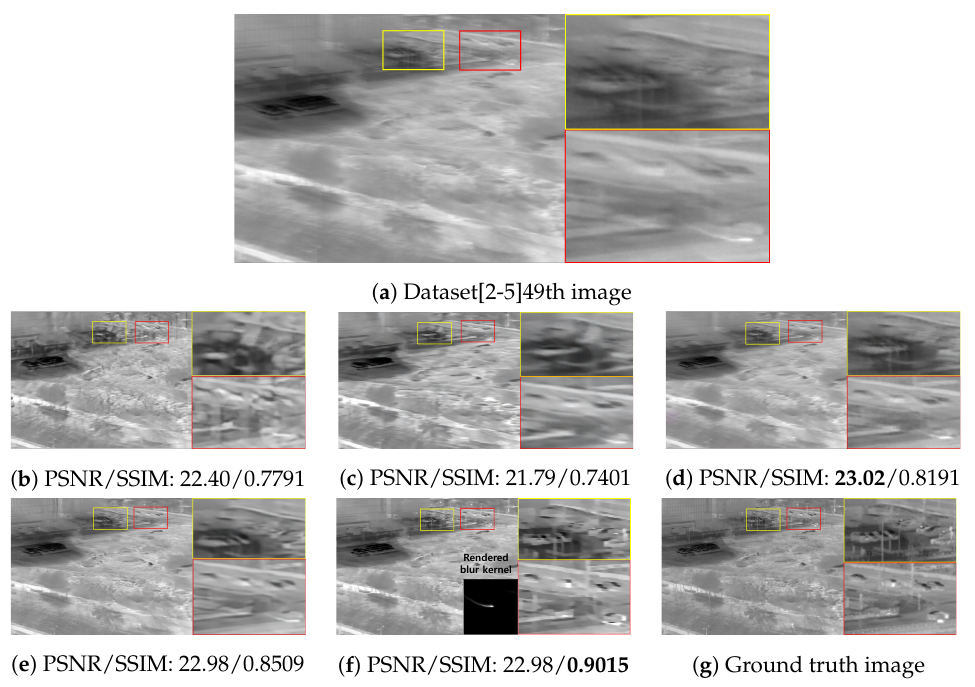
Figure 12. Qualitative comparison of deblurring results on the SBTI dataset [2-5]49th. ( a ) Synthetic blurry thermal image, ( b ) SRN [33], ( c ) SIUN [36], ( d ) DeblurGAN.v2 [35], ( e ) CDVD [34], ( f ) Ours, ( g ) GT.